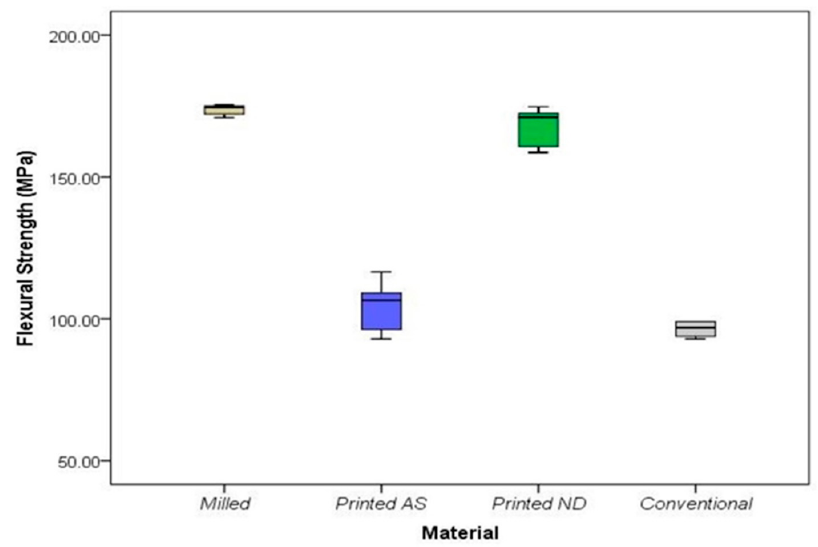
Figure 5. Flexural strength of the studied materials. Middle line represents the median, box outline represents the interquartile range (25th–75th percentiles), and the two whiskers represent the range (minimum–maximum).